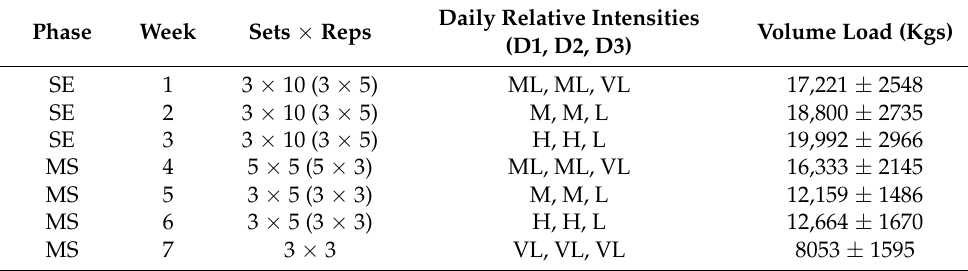
Table 2. Strength training program for 7 weeks.